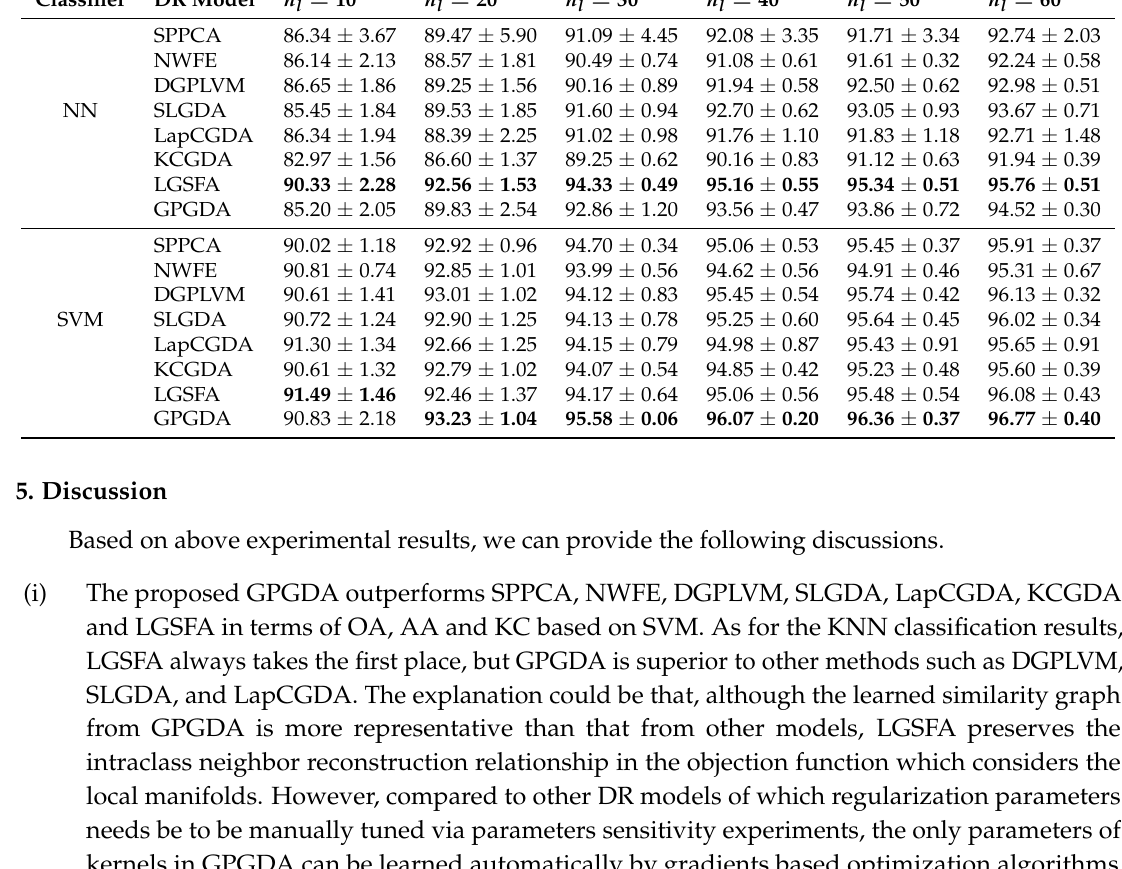
Table 9. Classification results with different amounts of training data on the Salinas data (OA ± STD (%)).